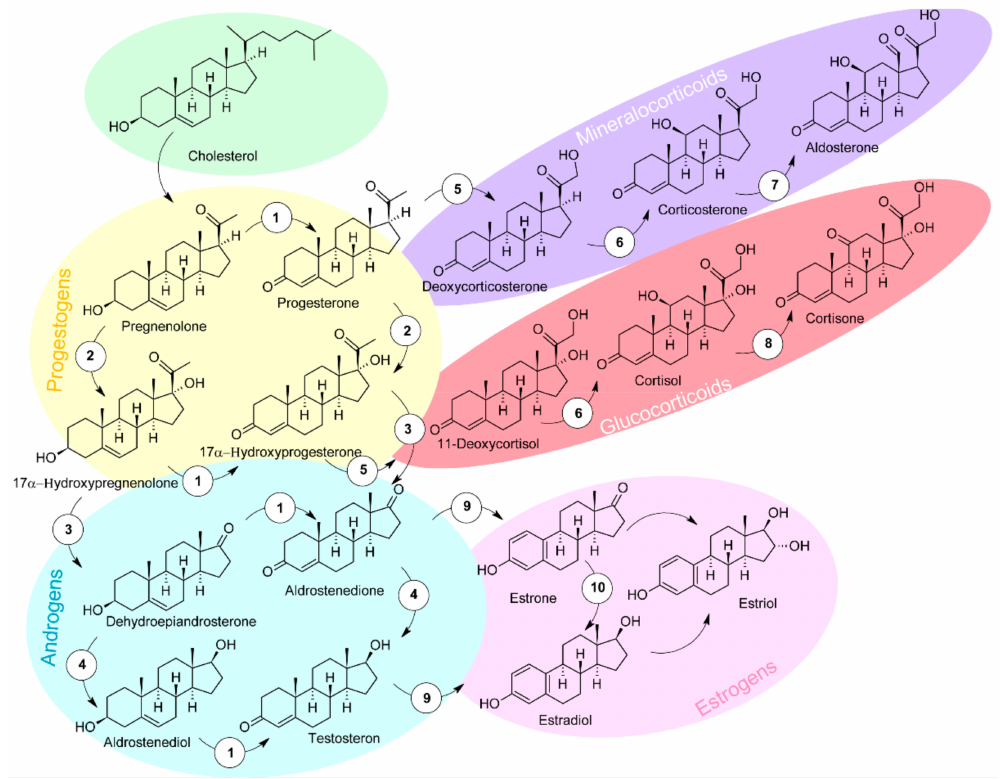
Figure 1. Biosynthesis and metabolism of steroid hormones. 1: 3 β -hydroxysteroid dehydrogenase type 2 (3 β -HSD2); 2: 17 α - hydroxylase; 3: 17,20-lyase; 4: 17 β -hydroxysteroid dehydrogenase type 3/5 (17 β -HSD 3/5); 5: 21-hydroxylase; 6: 11 β -hydroxylase; 7: aldosterone synthase; 8: 11 β -hydroxysteroid dehydrogenase type 2 (11 β -HSD2); 9: aromatase; 10: 17 β -hydroxysteroid dehydrogenase type 1/3 (17 β -HSD